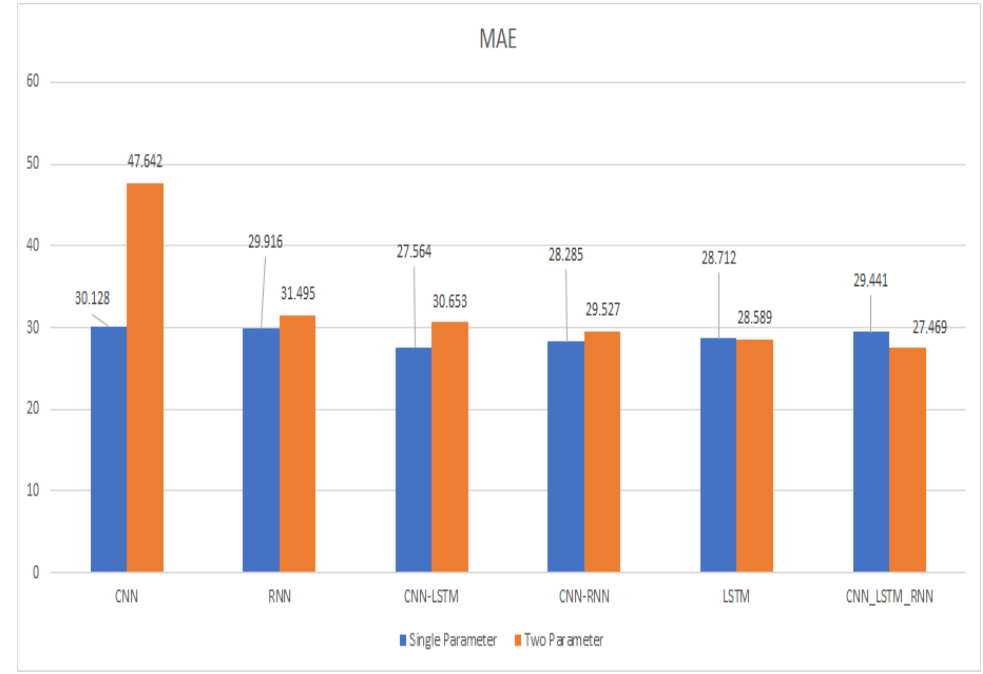
Figure 20. MAE comparison between various models.